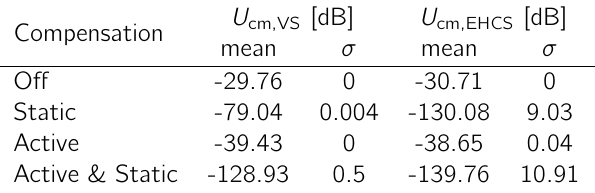
Table 1: The mean CMR without, with static and active compensation methods. The variances (cid:27) of the VS ( C v = 82 pF) and current source ( C c = 2 : 6 pF) are given for the frequency range 1 kHz to 1 MHz.